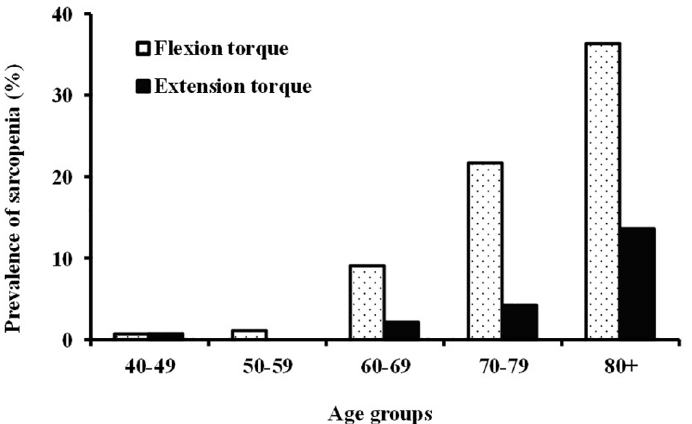
Fig 3. Prevalence of trunk sarcopenia. Values below the lower limit of reference intervals from young and healthy adults were defined as trunk sarcopenia. Subjects were divided into five groups: 40–49 (from 40 to 49 years of age), 50– 59 (from 50 to 59 years of age), 60–69 (from 60 to 69 years of age), 70–79 (from 70 to 79 years of age), and 80+ (80 years of age and